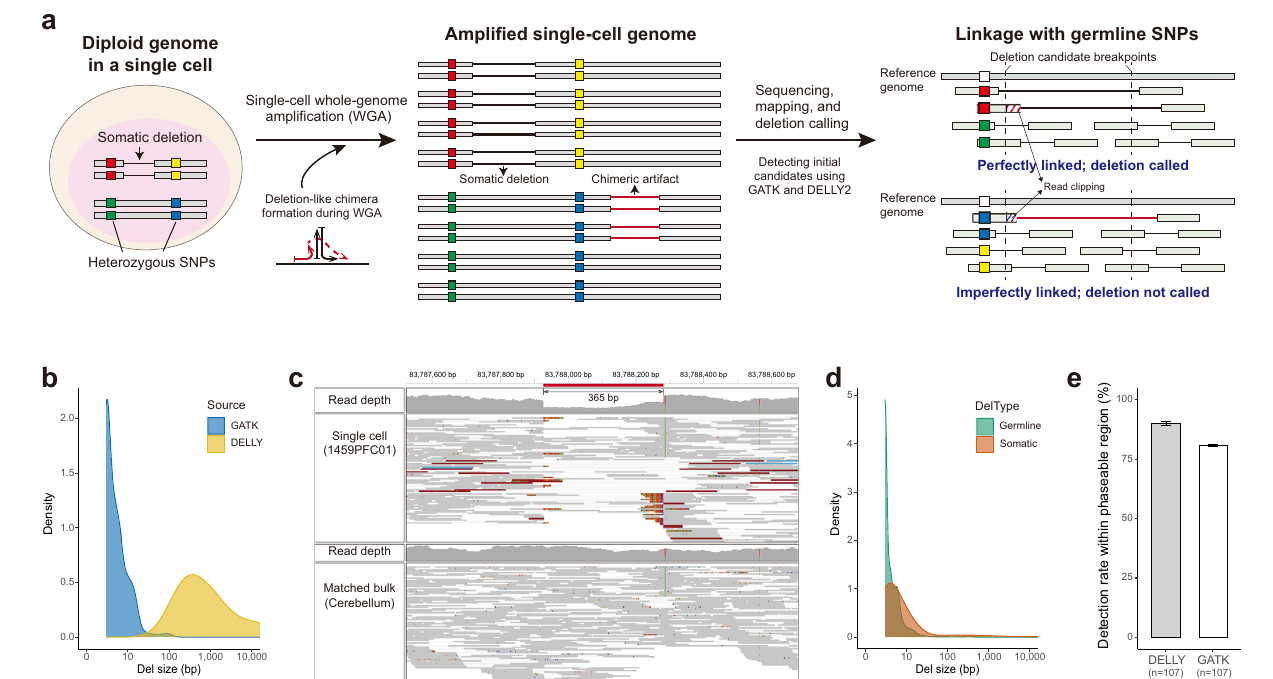
Fig. 1 | Linkage-based detection of somatic deletions in single-cell WGS data. a Schematic of PhaseDel. A true somatic deletion (black line) shows complete linkage with one allele (red) of a nearby heterozygous SNP whereas a deletion-like ampli fi cation artifact (red line) shows incomplete linkage with a nearby SNP allele (blue).PhaseDelutilizesrawcallsfromGATKandDELLY2methodsandmakes fi nal callsbased onthelinkagepatterns oftheinitialdeletioncandidates.Box fi lled with diagonal lines represents clipped part of the read. b Deletion size distribution of two initial callers, GATK and DELLY2. c Integrative Genomics Viewer (IGV) screen- shots of an example somatic deletion of 365bp identi fi ed by PhaseDel. Upper and